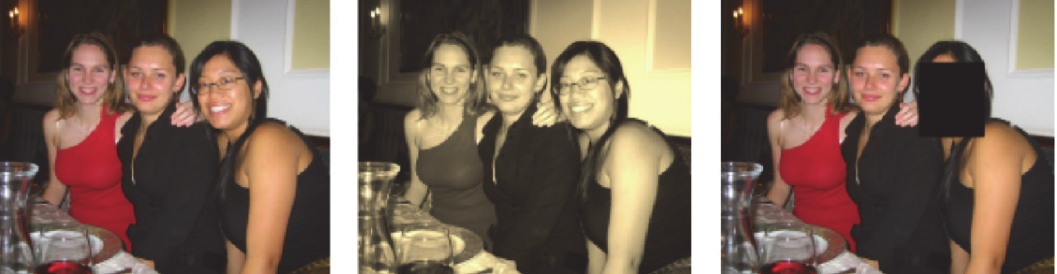
Figure 5: The three tested scenarios. An original image, an image with sepia filter applied, and an image with face removed.